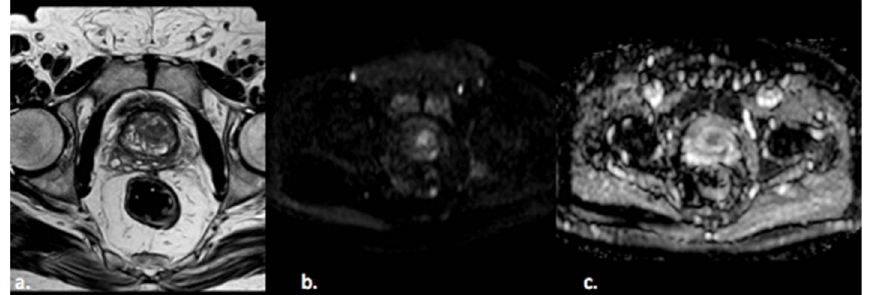
Figure 2. A 55-year old man with a PI-RADS 3 lesion in the left anterior segment of PZ of the midgland, moderately hypointense on T2-weighted images ( a ), hyperintense on DWI, and hypointense on ADC images ( b , c ).